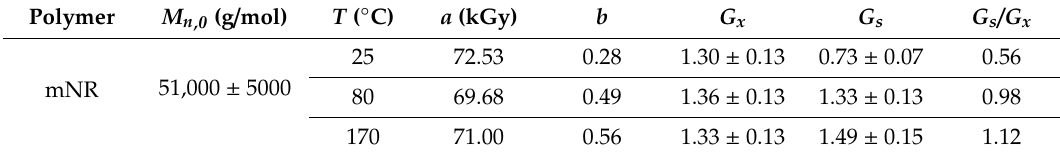
Figure 5. Charlesby–Pinner plots of mNR modified at 25, 80, and 170 °C with dose ranging from 0 to 200 kGy. Table 1. G-values of crosslinking (G x ) and scission (G s ) of EB irradiated mNR at various temperatures.